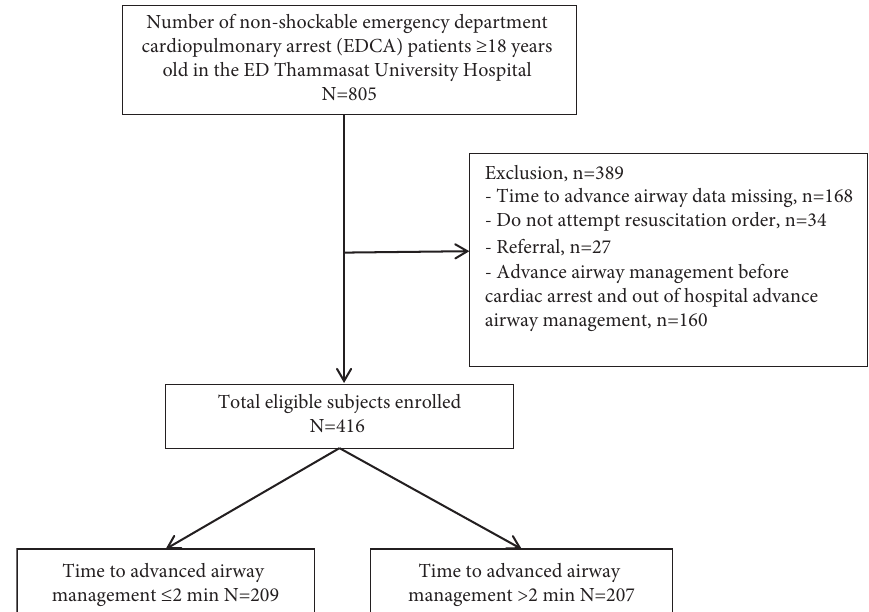
Figure 1: Flow diagram of the study population